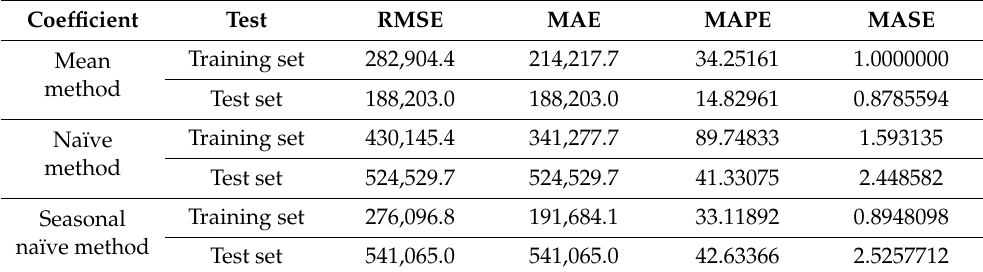
Figure 11. Total and partial autocorrelation. The blue dashed lines indicate whether the correlations Table 2. Test for evaluating the accuracy of the forecasts. are significantly different from zero. The performance of the predictions depends on the size of the prediction errors. It is a matter of comparing the predictions with the actual observed values. The smaller the